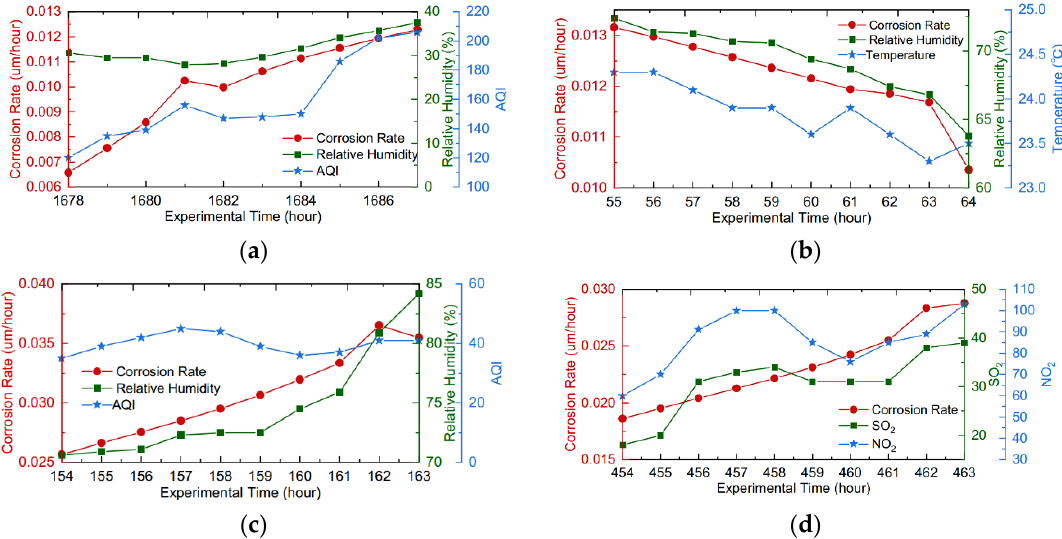
Figure 4. Curves of the four illustrative cases marked in Figure 3a: ( a ) Case 2-1; ( b ) Case 1-1; ( c ) Case 1-2; ( d ) Case 1-3.